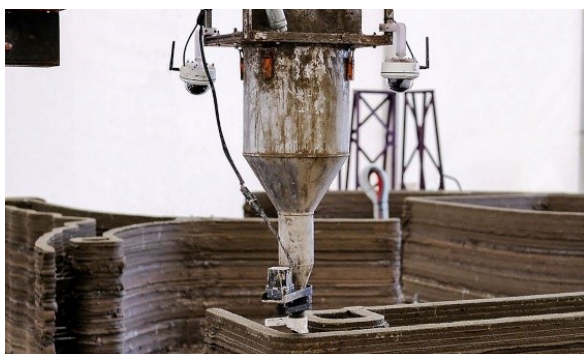
Figure 1. 3D concrete printer from PERI GmbH. Printable concrete is applied in layers and no formwork is required. Cameras are attached to the print head for visual monitoring of the printing process and results ©PERI GmbH (PERI GmbH, 2020a).